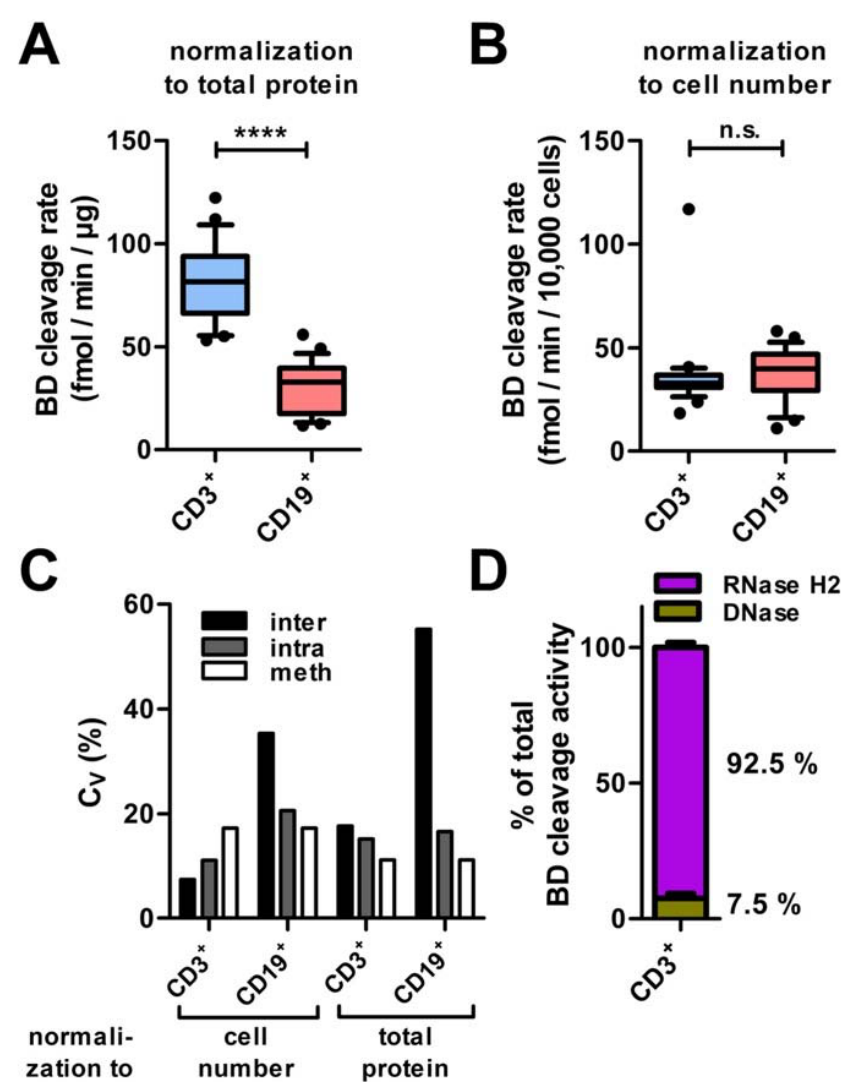
Figure 6. Control group benchmarks. ( A ) Substrate BD cleavage rates normalized to total protein in T cells were significantly higher than in B cells; activity was measured in single Ficoll ® -gradient and pipetting replicates; ( B ) RNase H2 activity normalized to cell number did not differ significantly, but showed significantly smaller variability in T cells; ( C ) strong inter-individual variability was observed in B cells, while inter- and intra-individual variability were approximately on the same level as methodological error (including cell isolation (Ficoll ® -gradient) and pipetting errors) in T cells. Intra -individual variability was assessed using quadruplicates of peripheral venous blood samples drawn from one healthy donor at five different time points. Methodological variability was determined in validation experiments; ( D ) the proportion of substrate BD cleavage activity due to DNase in the cell lysates was 7.5% of total cleavage activity (SD = 4%, n = 5); median is shown, boxes indicate 25th and 75th percentile, and whiskers indicate the 10th and 90th percentile. Normality could be assumed for all groups (Shapiro-Wilk test). Significance was tested via unpaired two-tailed t -test: **** p < 0.0001; n.s. not significant.